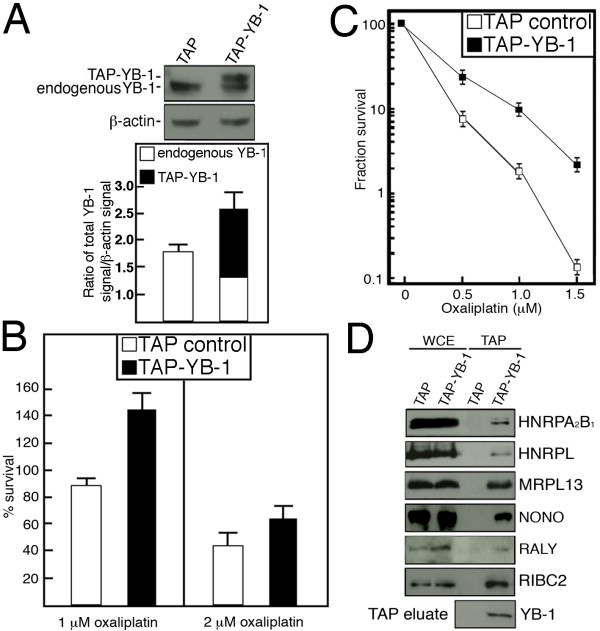
Increased oxaliplatin resistance in SW480 cells expressing the TAP-YB-1 construct and validation of TAP-YB-1 interaction with six identified protein from the LC-MS/MS. A) Representative Western blot analysis of SW480 clones expressing the TAP or the TAP-YB-1 constructs. β-actin was used as loading controls. The histogram below the Western blots indicates the endogenous and TAP-YB-1 expression levels in the indicated clones. B) Survival assays of SW480 clones expressing TAP or TAP-YB-1 constructs. Cells were treated with one or two μM of oxaliplatin for 18 h. Live cells were then counted with a hemacytometer by the trypan blue exclusion technique. Experiments were performed in duplicate. Bars represent SEM. C) Clonogenic assays with SW480 clones expressing TAP or TAP-YB-1 constructs. Cells were treated with the indicated concentrations of oxaliplatin for 18 hours and then plated in 90-mm petri dishes with fresh media without drugs for 10 days. Survival fraction represents the number of colonies after treatment divided by the number of colonies without treatment (in %). Results represent the mean ± SEM of duplicate experiments. D) TAP-YB-1 interaction of HNRPA2B1, HNRPL, MRPL13, NONO, RALY, and RIBC2 with the YB-1 protein. Proteins from TAP and TAP-YB-1 expressing SW480 cells were eluted from the streptavidin beads and analyzed by SDS-PAGE with antibodies against the indicated proteins. Proteins were revealed with an ECL Plus kit. WCE represents the whole cell lysate. TAP represents the protein eluted from the streptavidin beads.